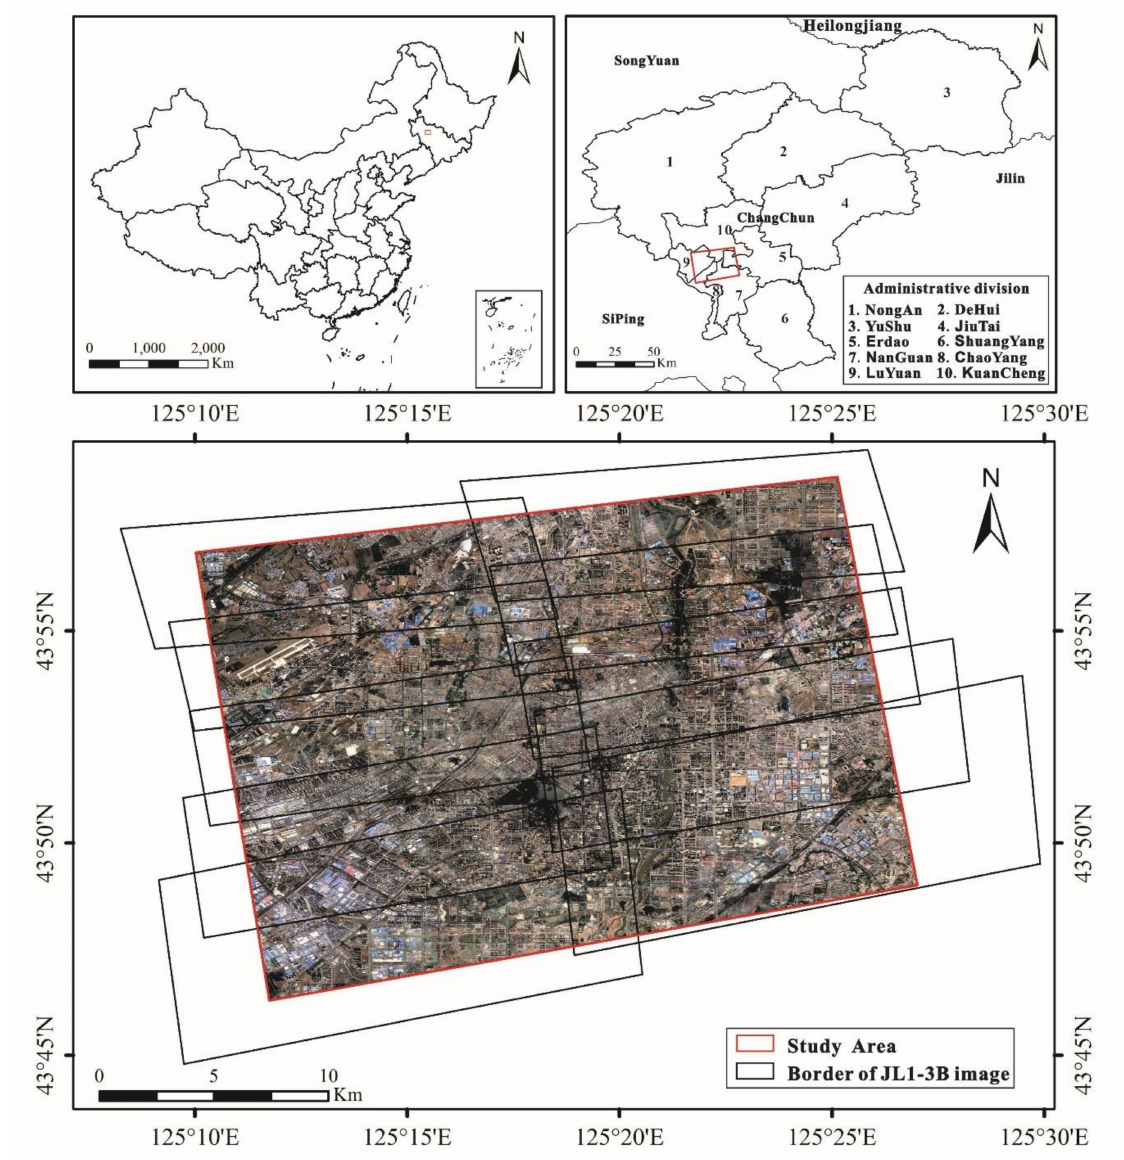
Figure 1. The basic information of the research area, superimposed on the Google Earth image. The red and black regions represent the border of the study area and each part of the JL1-3B data,